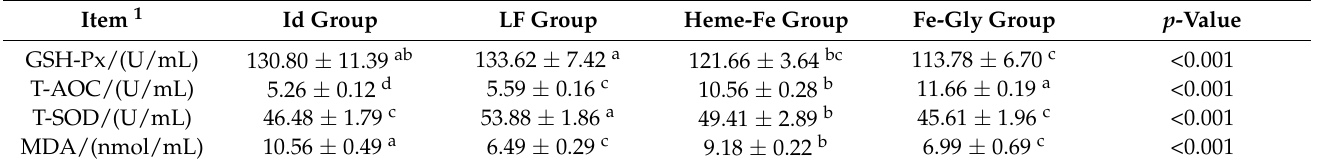
Table 7. Effects of iron sources on serum antioxidant indices in neonate